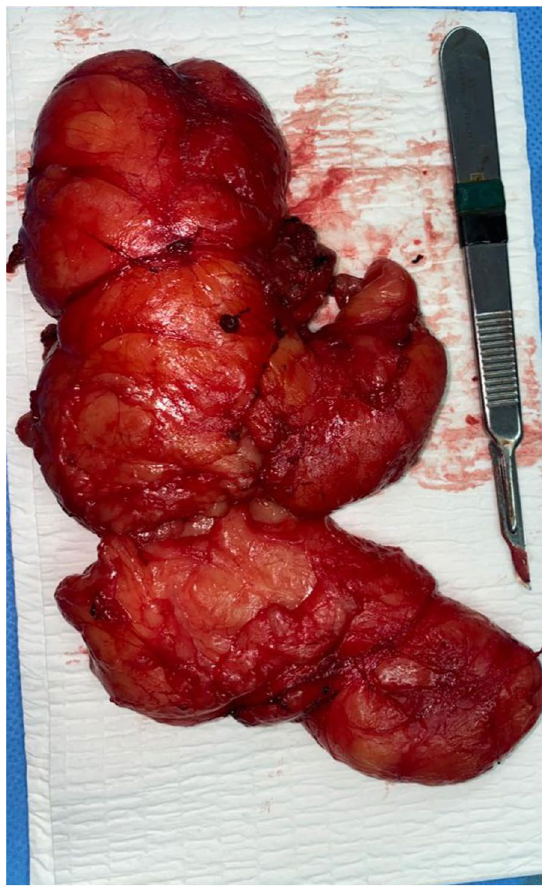
Fig. 5 Photo showing the appearance and volume of the lipoma after surgical